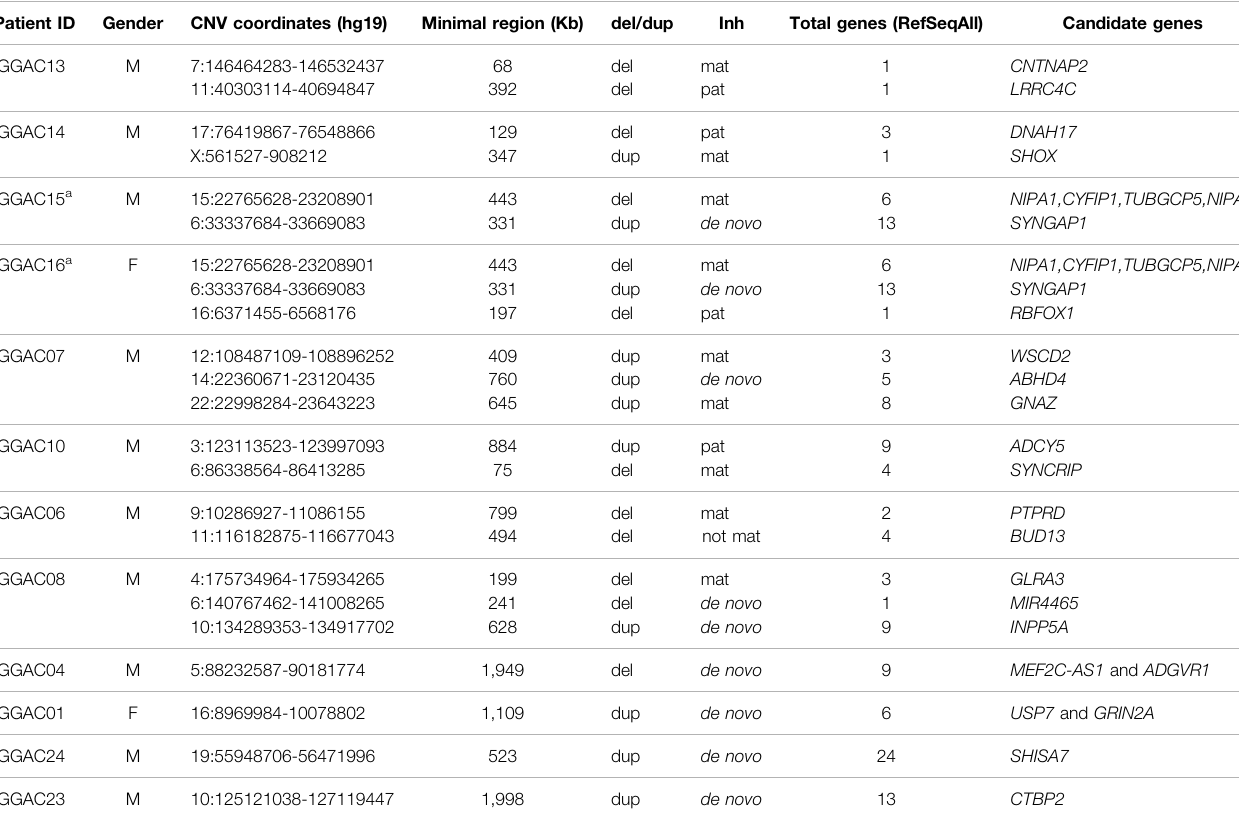
TABLE 2 | Overview of the CNVs found in the